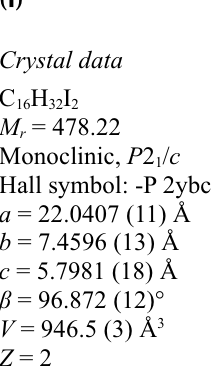
The projection of the crystal structure of (I) along the c axis.